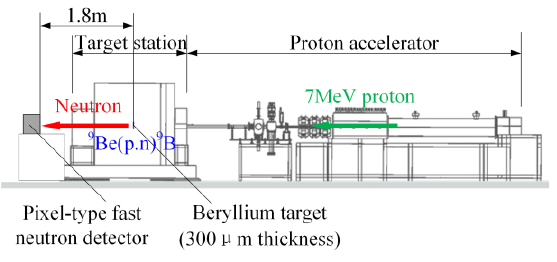
Fig. 1. Structure diagram of RANS.